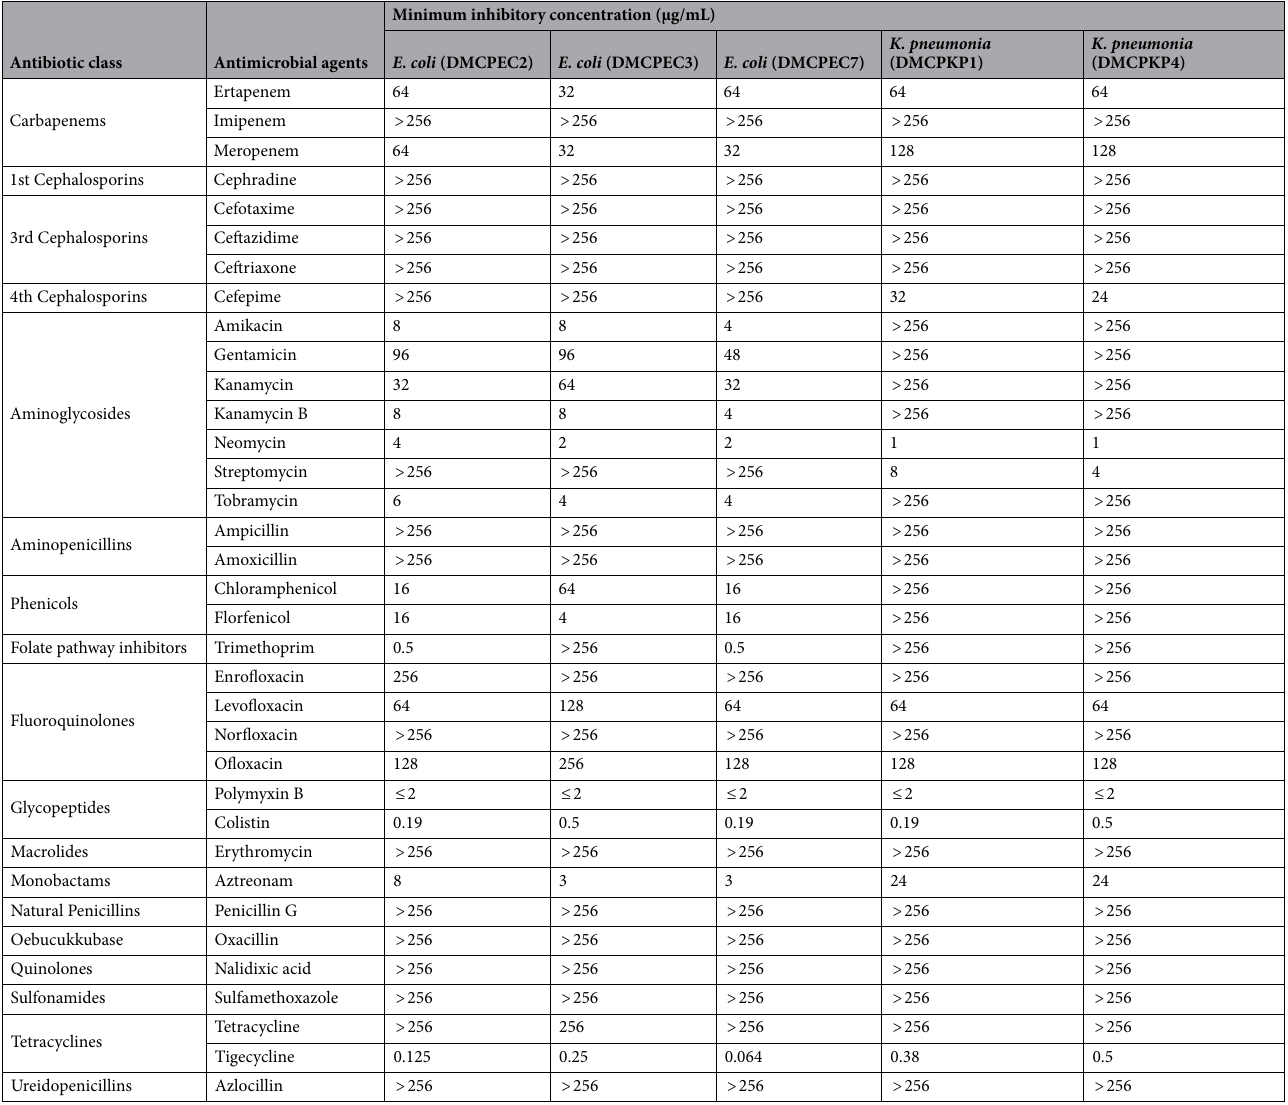
Table 1. Minimum inhibitory concentration level of 5 carbapenemase-producing strains against various antibiotics (μg/mL). Either broth or E-test methods were performed following recommendation of Clinical